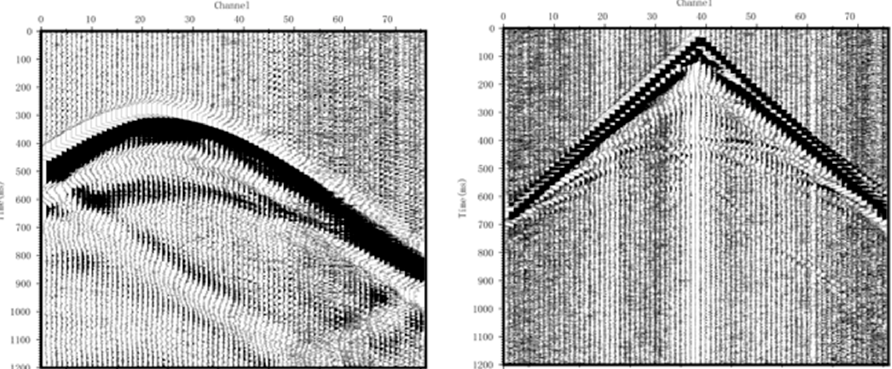
Figure 12. Example shot gathers of the active ( right ) and passive ( left ) synthetic seismic datasets with real noise.